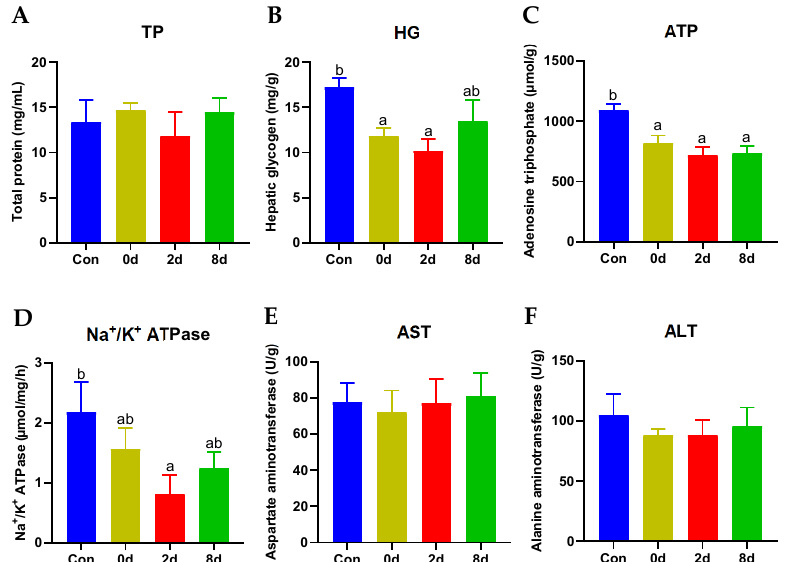
Figure 2. Effects of chronic hypothermia on hepatic biochemical parameters of freshwater drum. ( A ) Total protein, TP; ( B ) Hepatic glycogen, HG; ( C ) Adenosine triphosphate, ATP; ( D ) Na + /K + ATPase. ( E ) Aspartate aminotransferase, AST; ( F ) Alanine aminotransferase, ALT. Data were calculated by one-way ANOVA analysis with SPSS 23.0. The significant differences are considered to exist when p < 0.05, and marked with different letters. Results were expressed as mean ± SEM, n = 6.